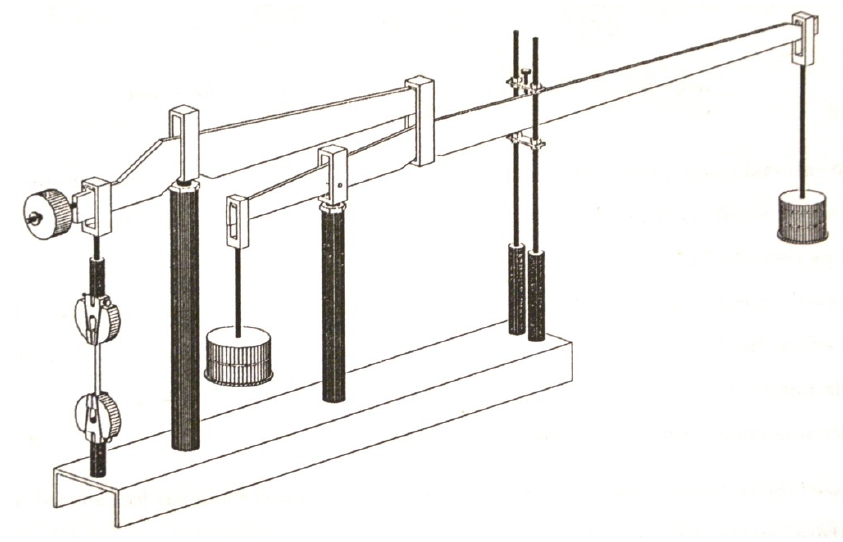
Figure 4. Experimental testing device [33].